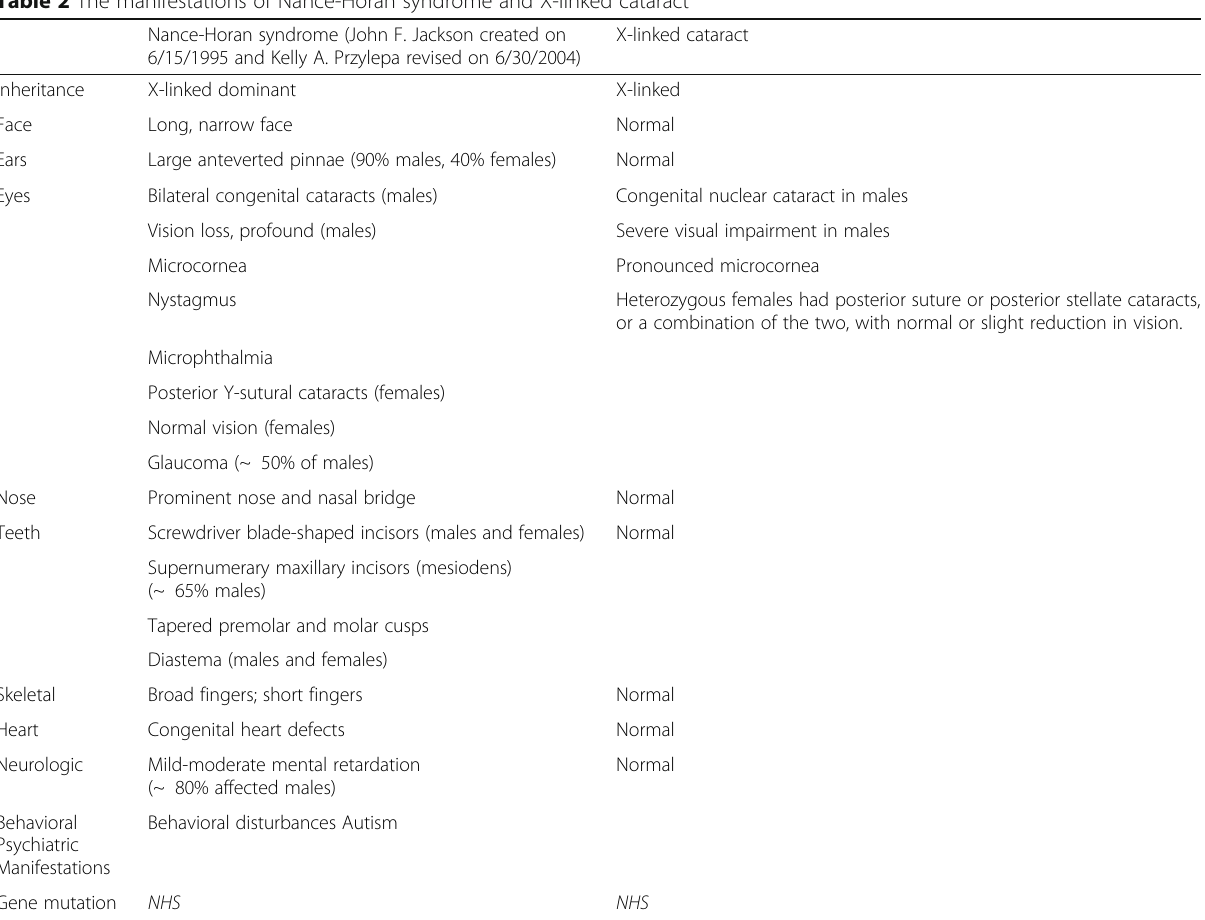
Table 2 The manifestations of Nance-Horan syndrome and X-linked cataract Nance-Horan syndrome (John F. Jackson created on 6/15/1995 and Kelly A. Przylepa revised on